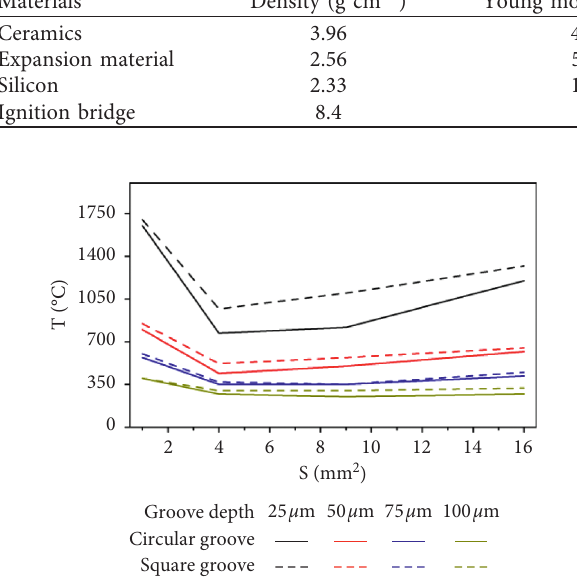
Figure 3: Temperature of the chip is cracked under different groove